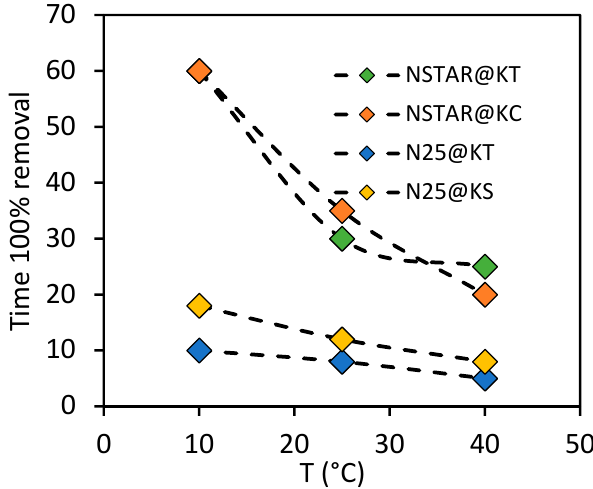
Figure 6. Time for 100% removal of Cr(VI) with different types of material at different temperatures. [Cr(VI)] = 64 µM, NSTAR@AL= 1 g, Fe:Cr MR = 55 and pH = 3. 0